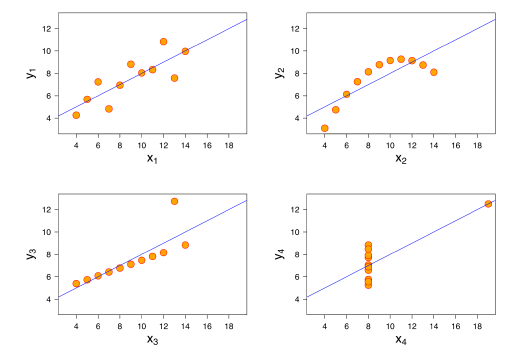
Figure 1. Anscombe’s quartet (taken from [2]), four datasets that have nearly identical summary statistics but we can clearly identify di ff erences in a